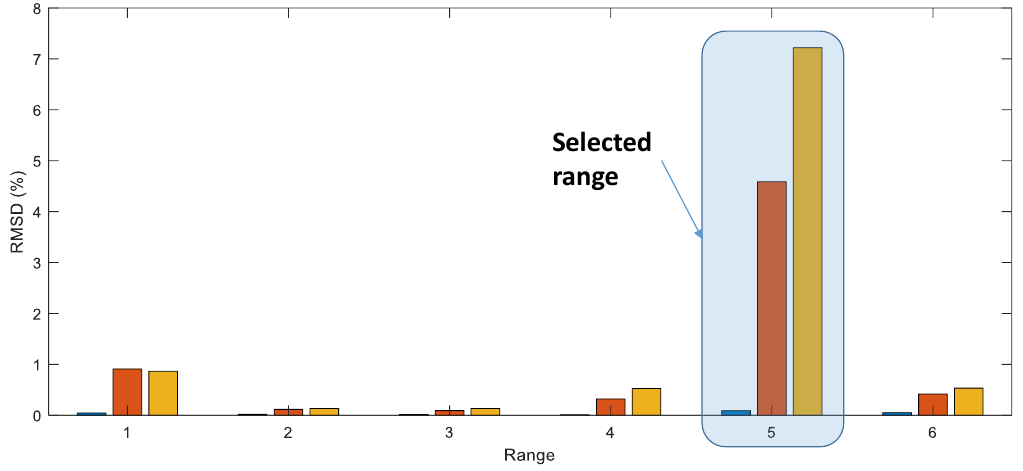
Figure 13. Selection of the frequency range for damage assessment.